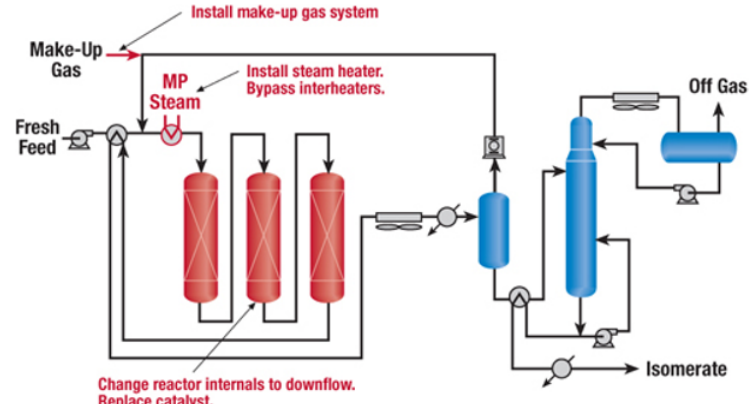
Figure 7. Par. Isom. Process by UOP.